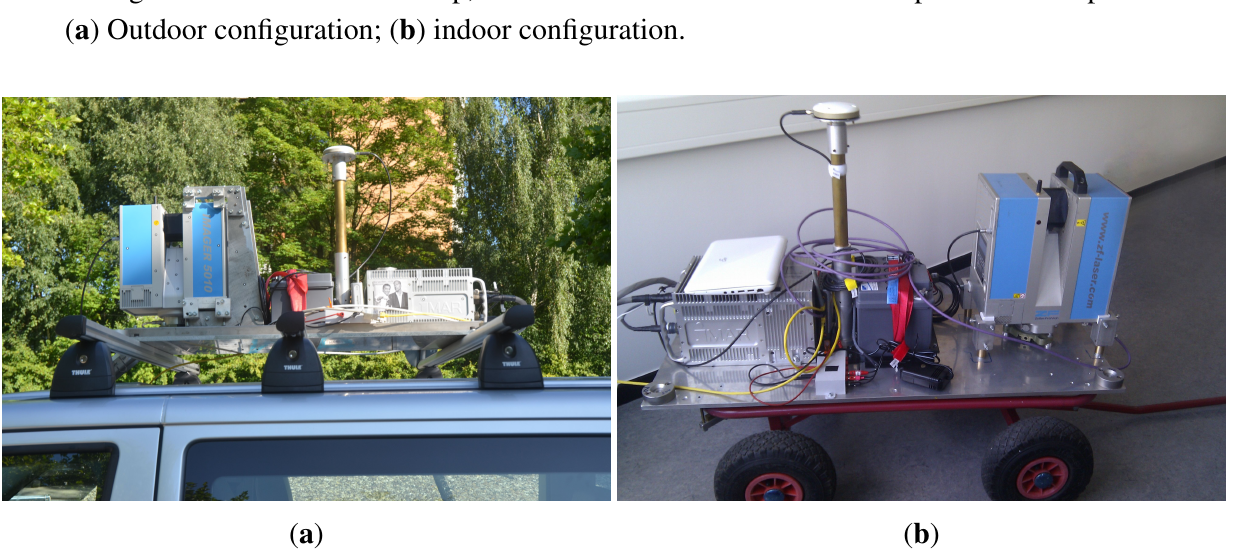
Figure 1. The mobile mapping system; the left shows the system mounted on a van outdoors; the right shows the indoor set-up, where the GNSS-antenna can be replaced with a